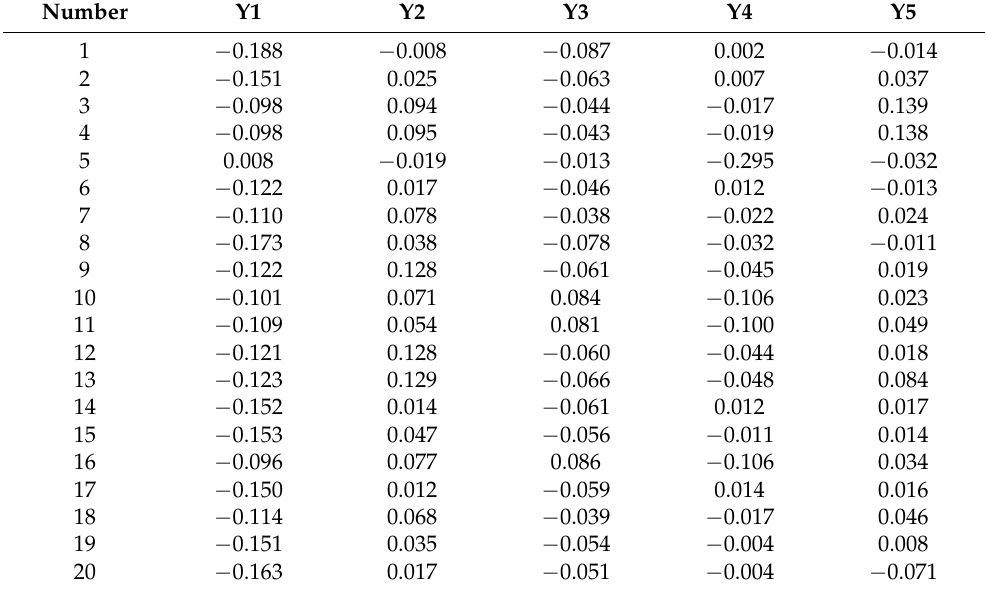
Table 3. Sample data after feature